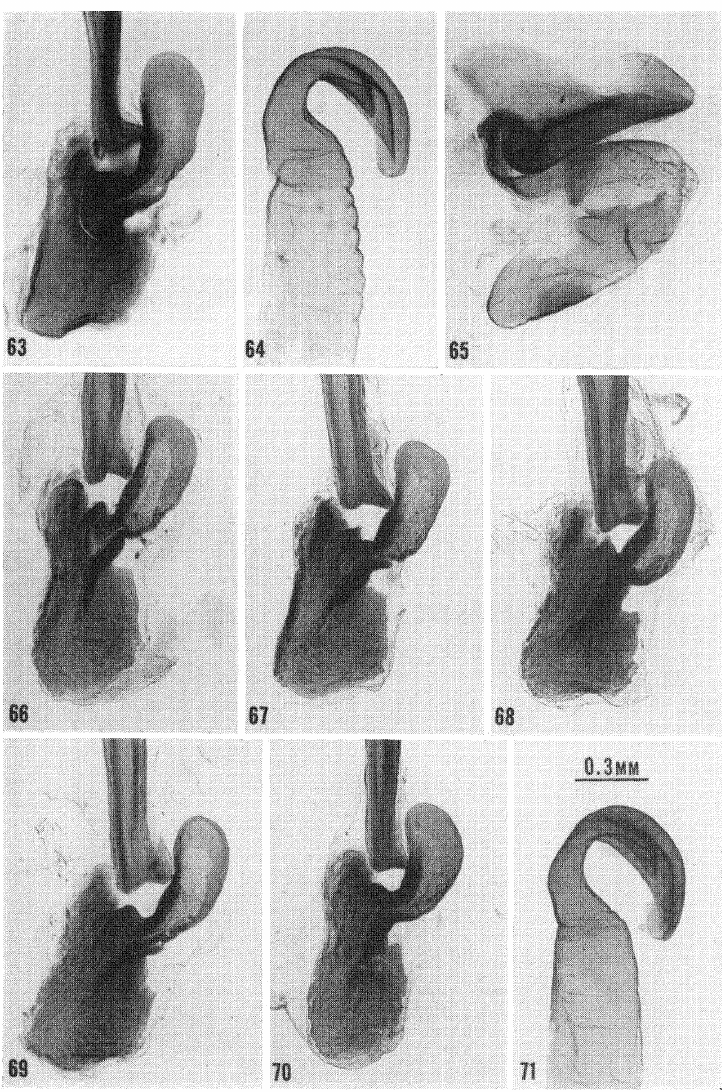
Figs. 63-71. Calucina patula. (N). From a laboratory culture origi- nating in Costa Rica. (all to scale shown in Fig.